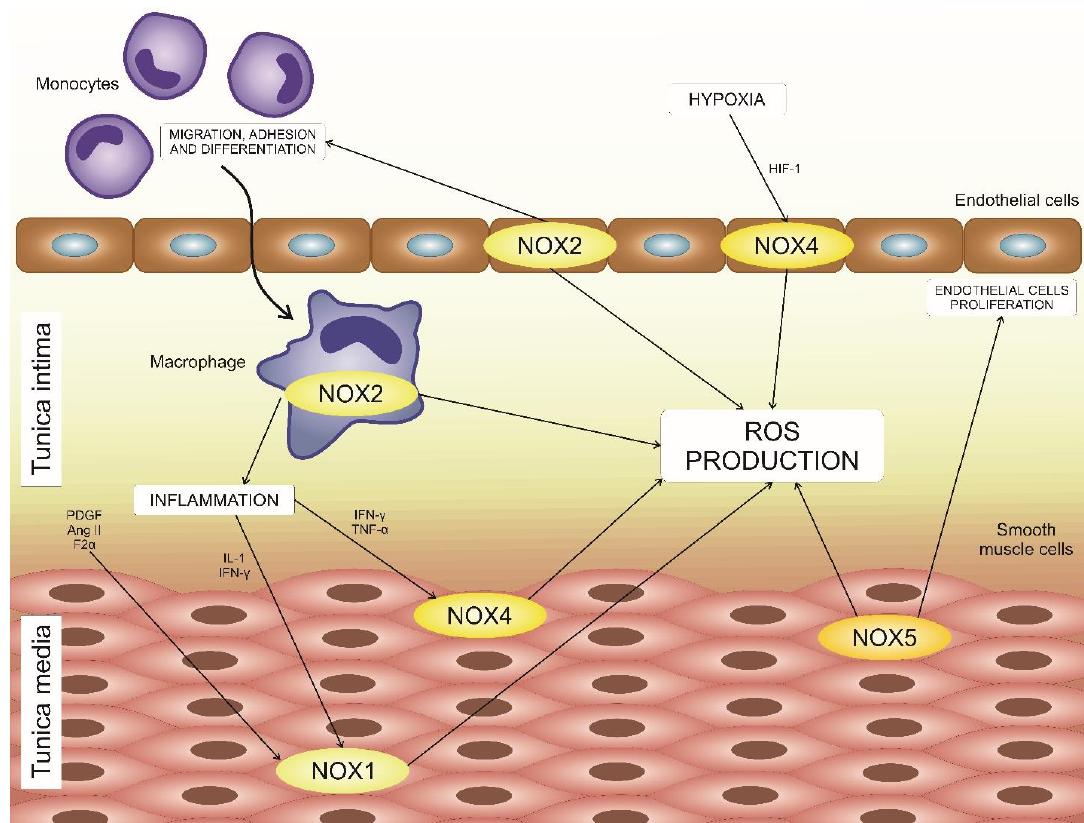
Figure 1. NOX isoforms expressed in vascular cells. NOX1, NOX2, NOX4, and NOX5 can be found in human vascular wall tissue. NOX1, NOX4, and NOX5 are expressed by vascular smooth muscular cells, while NOX2 and NOX4 are present in the endothelium. Macrophages recruited to the subendothelial cells also express NOX2. Together, these enzymes contribute to reactive oxygen species (ROS) formation in the vascular wall and play an important role in the development of local inflammatory processes.